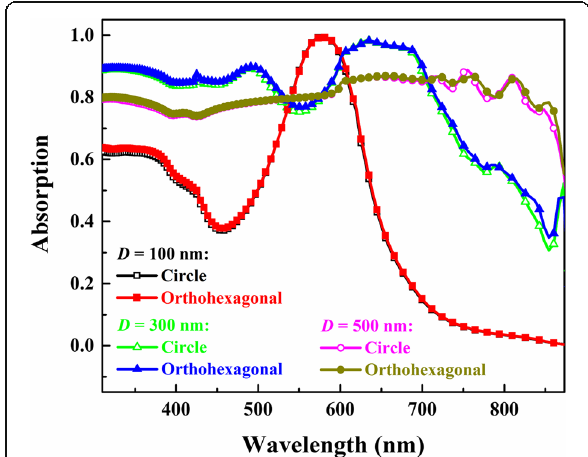
Fig. 6 Comparison of the absorption spectra of the GaAs pure NW arrays with the circle and orthohexagonal wire cross-sections. The array period and wire length are 600 nm and 2 μ m, respectively. The wire volumes for the corresponding NW arrays are the same and characterized by the diameter (100, 300, and 500 nm) of the NWs with a circle